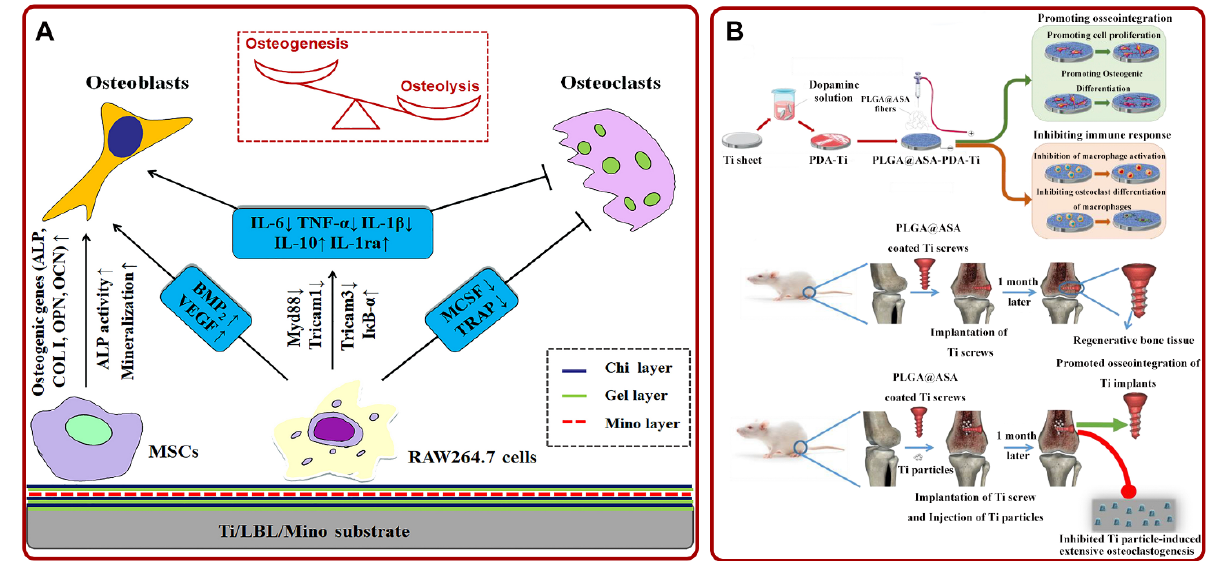
Figure 5. ( A ) Schematic diagram of the potential mechanism that Ti/LBL/Mino promoted osteogenesis via regulating MSCs and macrophages. Adapted with permission from Ref. [177]. Copyright 2019, Elsevier; ( B ) the preparation process and experimental diagram of PLGA@ASA-PDA-Ti. Adapted with permission from Ref. [181]. Copyright 2020, Elsevier. Abbreviations: Chi: chitosan; Gel: gelatin; Mino: minocycline; MSCs: mesenchymal stem cell; PLGA: poly (lactic-co-glycolic acid); ASA: aspirin; PDA: polydopamine; Ti: titanium.